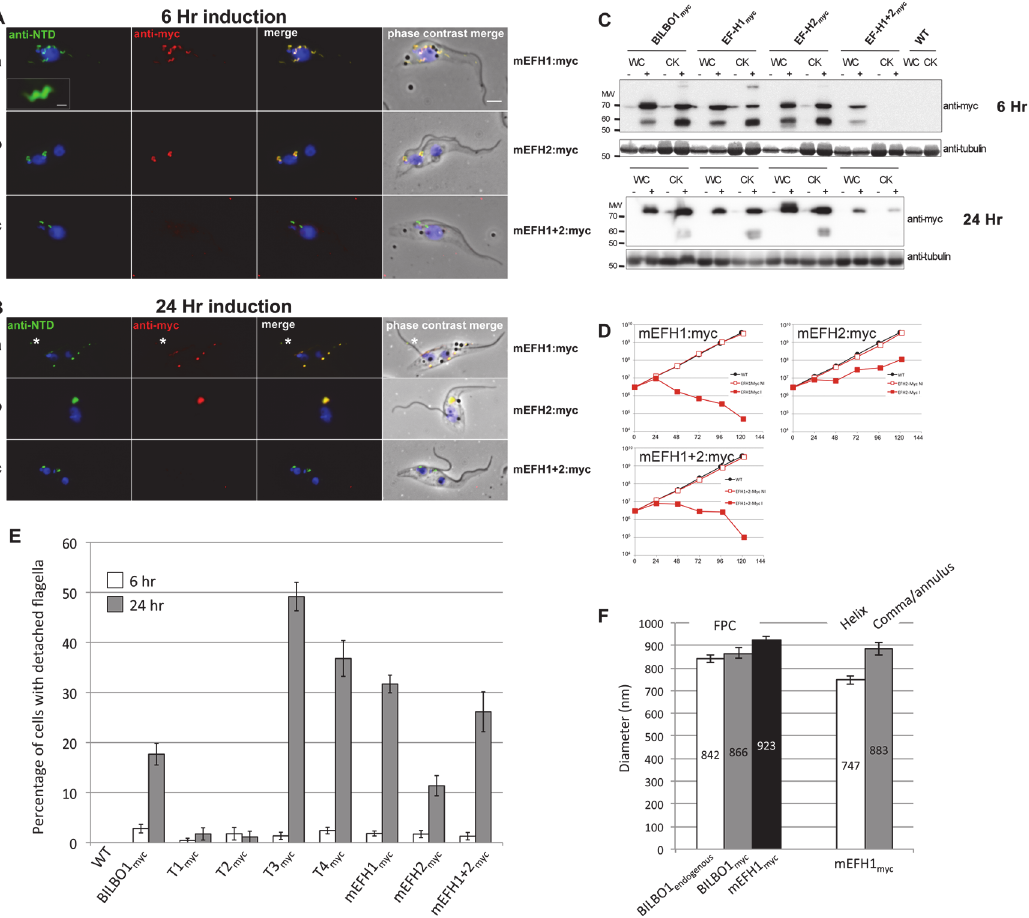
Fig 7. The EF-hand domains modulate the morphology of polymers formed by BILBO1. (A) Immunofluorescence labelling of cytoskeletons from cells expressing mEFH1:myc, mEFH2:myc, mEFH1+2:myc using anti-NTD (green) and anti-myc (red) after six hours of induction. Scale bar in the magnified inset represent 1 μ m. Scale bar for all other images represents 5 μ m. (B) Immunofluorescence labelling of cytoskeleton extracted cells expressing mEFH1:myc, mEFH2:myc, mEFH1+2:myc using anti-NTD (green) and anti-myc (red) after 24 hours of induction. The asterisks indicate a dot in the new detached flagellum. (C) Western-blot of corresponding cells. 2.10 6 cells (WC) or cytoskeletons (CK) non-induced (-) and induced (+) for six hours, were loaded on a 10% SDS-PAGE, transferred and immuno-probed with anti-myc and anti-tubulin as loading control. WT is the non-transfected parental cell line. All expressed proteins except mEFH1+2:myc are insoluble. (D) Growth curves of the parental cell line (WT, black) compared to the cell lines non-induced (NI, red open squares) or induced (I, red closed square) for the expression of mEFH1, mEFH2, mEFH1+2 myc-tagged proteins. (E) Overexpression of BILBO1 coiled-coil truncations or EF-hand domain mutations induces detached flagellum phenotypes. The percentage of cells with a detached flagellum was determined using phase contrast microscopy after six or 24 hours of protein expression. (F) WT cells or cells expressing recombinant proteins (induced for six hours), were fixed and immunolabelled with anti-myc and anti-NTD. The graph represents the measurements of the FPC diameter in WT cells, in BILBO1: myc, mEFH1:myc, mEFH2:myc and mEFH1+2:myc expressing cell lines. The graph also shows the diameter of the helix and comma/annulus shaped polymers formed by